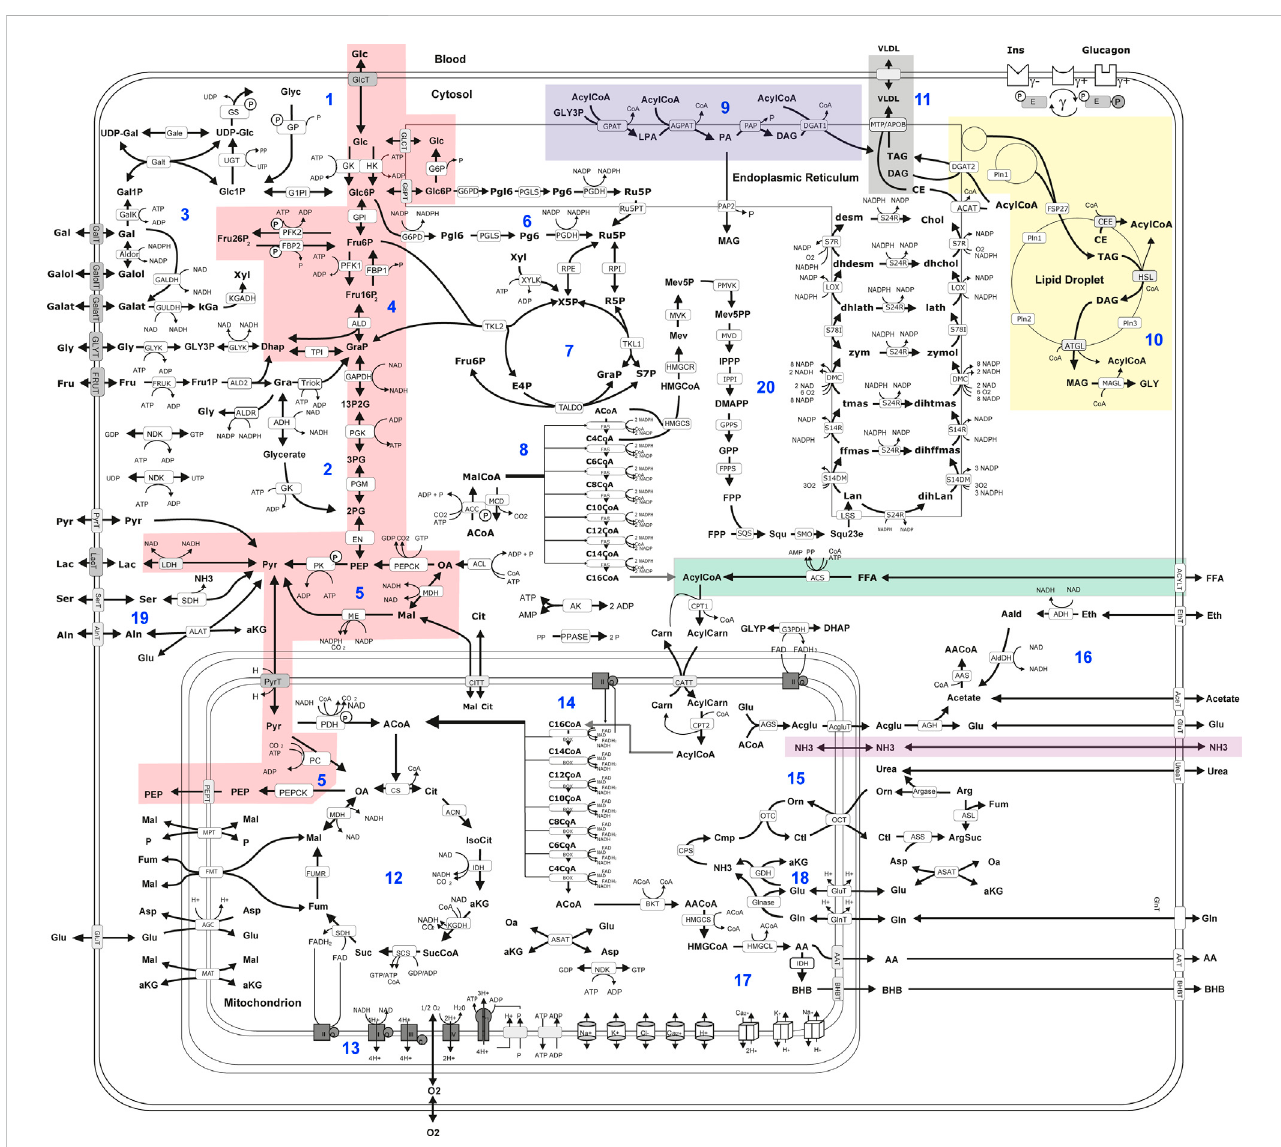
FIGURE 2 Scheme of liver metabolism model adapted from Bernd et al. (Berndt et al., 2018a). 16. Reactions and transport processes between compartments are symbolizedby arrows. Single pathwaysare numbered in blue: (Mathew et al.,2022) glycogen metabolism (Bussler et al., 2017), fructosemetabolism (Lonardo etal.,2015),galactosemetabolism(Sivell,2019),glycolysis(WongandSingal,2020),gluconeogenesis(CaldwellandArgo,2010),oxidativepentosephosphate pathway (Seyama and Kokudo, 2009), non-oxidative pentose phosphate pathway (Lalazar et al., 2008), fatty acid synthesis (Vos et al., 2014), triglyceride synthesis (De Gasperi et al., 2016), synthesis and degradation of lipid droplets (Gorowska-Kowolik et al., 2017), synthesis of very low density lipoprotein (vldl) (Berndt et al., 2021a), tricarbonic acid cycle (Berndt et al., 2021b), respiratory chain and oxidative phosphorylation (Berndt et al., 2020), β -oxidation of fatty acids(Berndtetal.,2019),ureacycle(Berndtetal.,2018a),ethanolmetabolism(Kespohletal.,2020),ketonebodysynthesis (Boydetal.,2020),glutamate and glutaminemetabolism (Ratziu et al.,2005);serine and alanineutilization (Chalasani etal., 2018),cholesterol synthesis. Lipid dropletsynthesis and degradation pathway include de novo synthesis of lipid droplets, lipid droplet fi lling, lipid droplet growth and fusion as well as lipid droplet degradation in dependence of regulatorysurfaceproteins45.Smallcylindersandcubessymbolizeionchannelsandiontransporters.Doublearrowsindicatereversiblereactions,whichmay proceed in both directions according to the value of the thermodynamic equilibrium constant and cellular concentrations of their reactants. Reactions are labeledbytheshortnamesofthecatalyzingenzymeormembranetransportergiveninthesmallboxesattachedtothereactionsarrow.Highlightedmetabolic pathways show association with MRE imaging parameters: gluconeogenesis (red); triacylglycerol (tag) synthesis (blue); tag storage (yellow); fatty acid uptake (green);verylowdensitylipoprotein(vldl)export(grey);ammoniauptake(purple).Metabolitesaredenotedbytheirshortnames.Fullnamesofmetabolitesand kinetic rate laws of reaction rates are outlined in Berndt et al. (2018a) and Wallstab et al.